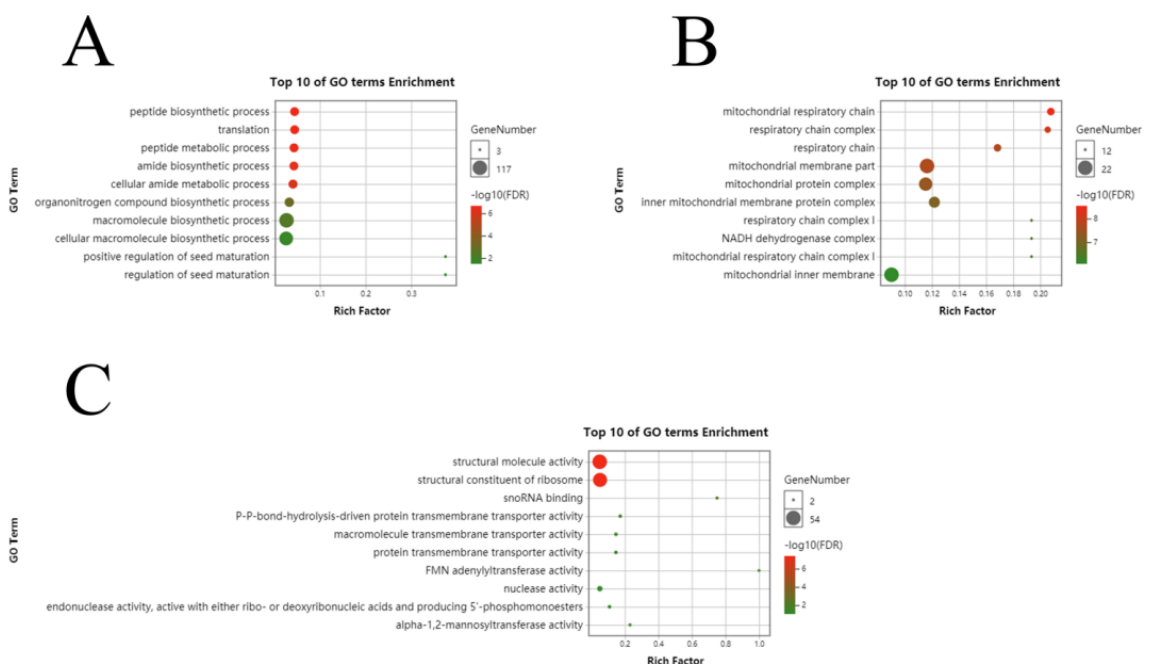
Figure 5. GO analysis of differential genes between Xinluzao 50 and Xinluzao 50 FLM in ( A ) biological processes, ( B ) cellular components, and ( C ) molecular function.